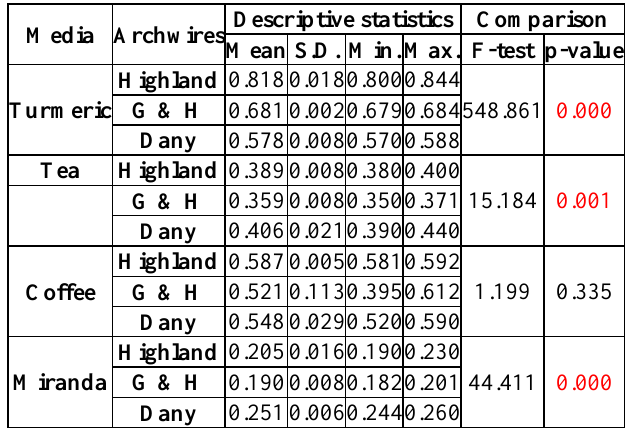
Table 2: Descriptive statistics and comparison of the degree of color absorption after 14 days of immersion.